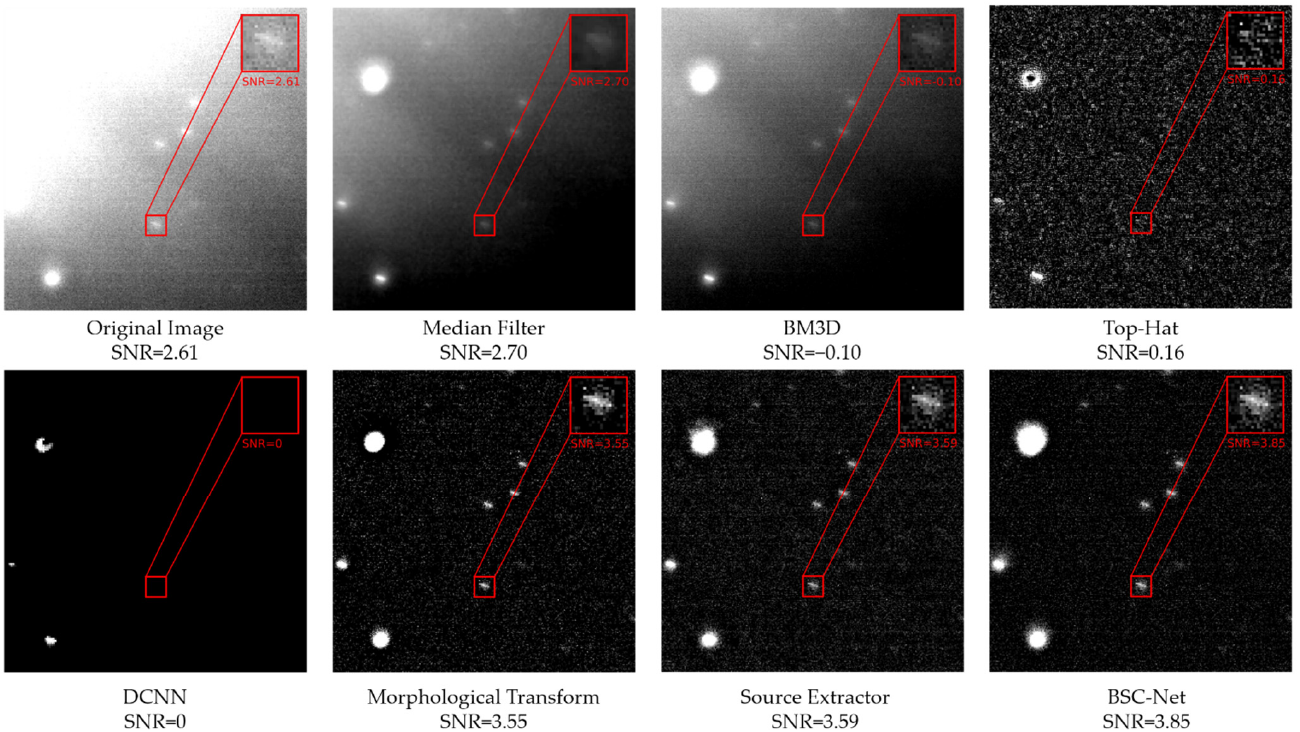
Figure 10. Results of the local highlight stray light in different algorithms (RMS = 226.55).